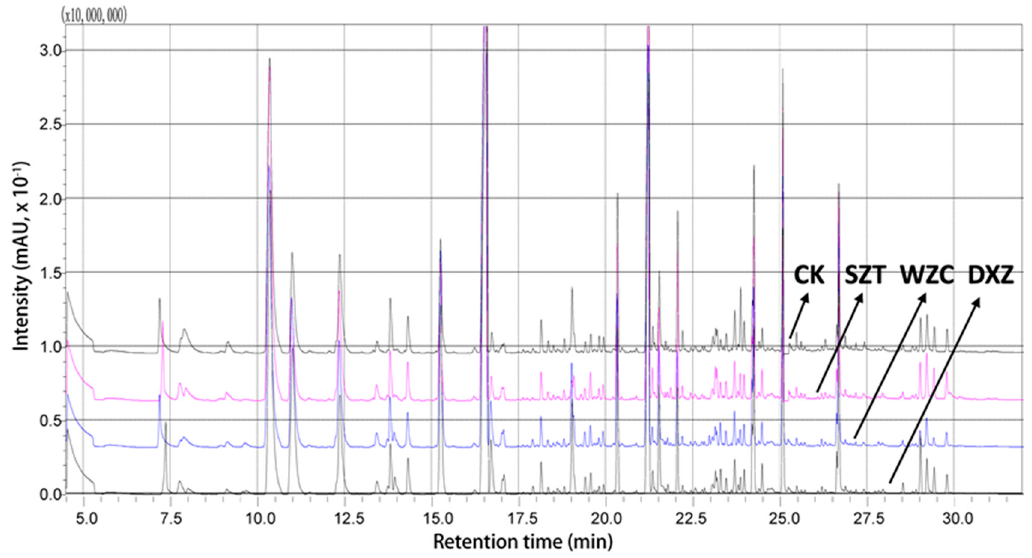
Figure 4. SPME-GC-MS total ion chromatogram of the volatile compounds for, from top to bottom, the blank (CK), triadimefon-treated (SZT), tebuconazole-treated (WZC), and paclobutrazol-treated (DXZ) wine samples.